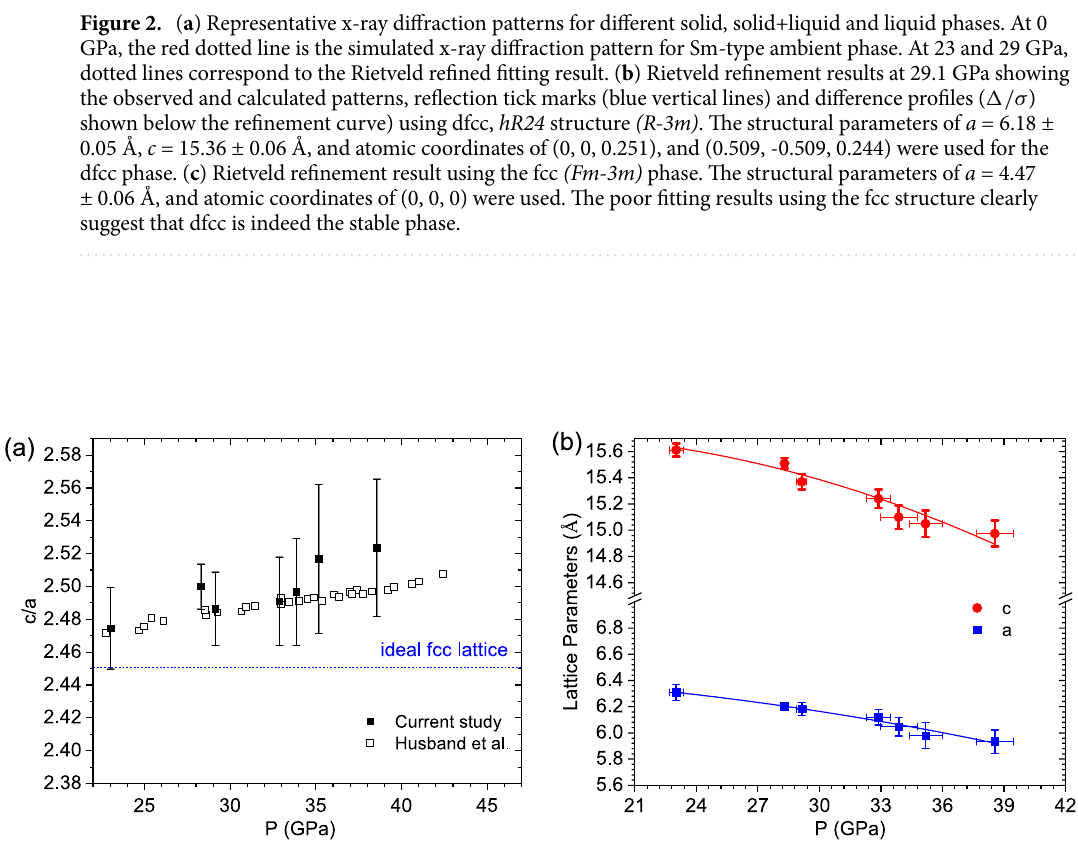
Figure 3. ( a ) c/a ratio for the dfcc phase. The dotted line represents the expected c/a ratios for an ideal fcc phase. Solid symbols are data from our current study, open symbols are data from Husband et al. 11 . The large error bar in our data is due to the broader peak features owing to the pink beam. ( b ) Calculated lattice parameters from the diffraction